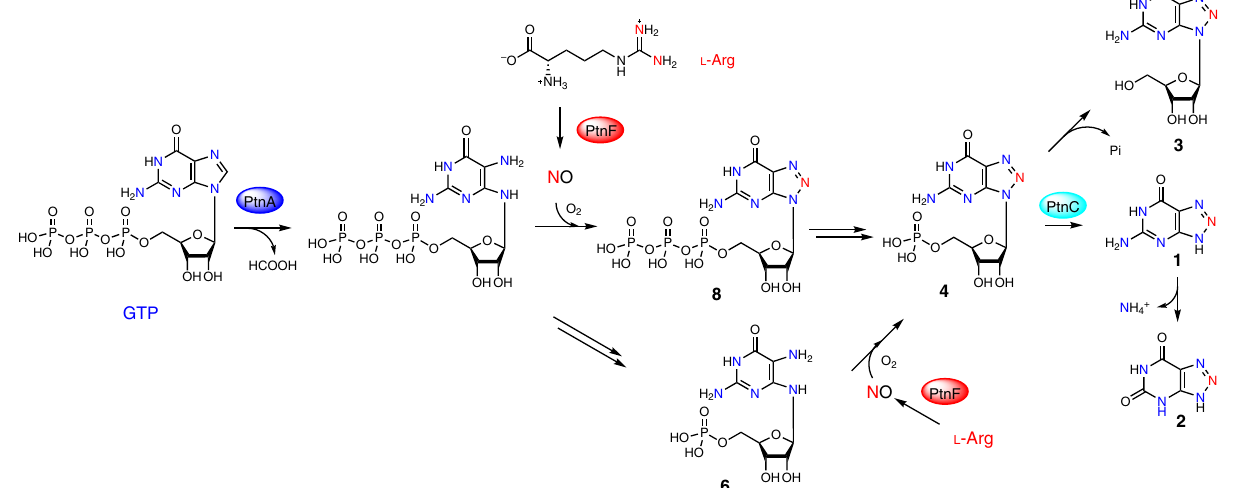
Fig. 2 Proposed biosynthetic route to 8-azaguanine (1) based on this study. The GCH I-like enzyme PtnA is proposed to catalyze the hydrolytic cleavage of C8 of GTP. The resulting product 2,5-diaminopyrimidine triphosphate could combine with a NO-derived reactive species to afford 8-azaguanosine triphosphate ( 8 ), and followed by pyrophosphate release by host enzyme(s). Alternatively, the compound 2,5-diaminopyrimidine triphosphate could fi rst undergo pyrophosphate release and then followed by triazole formation to afford 4